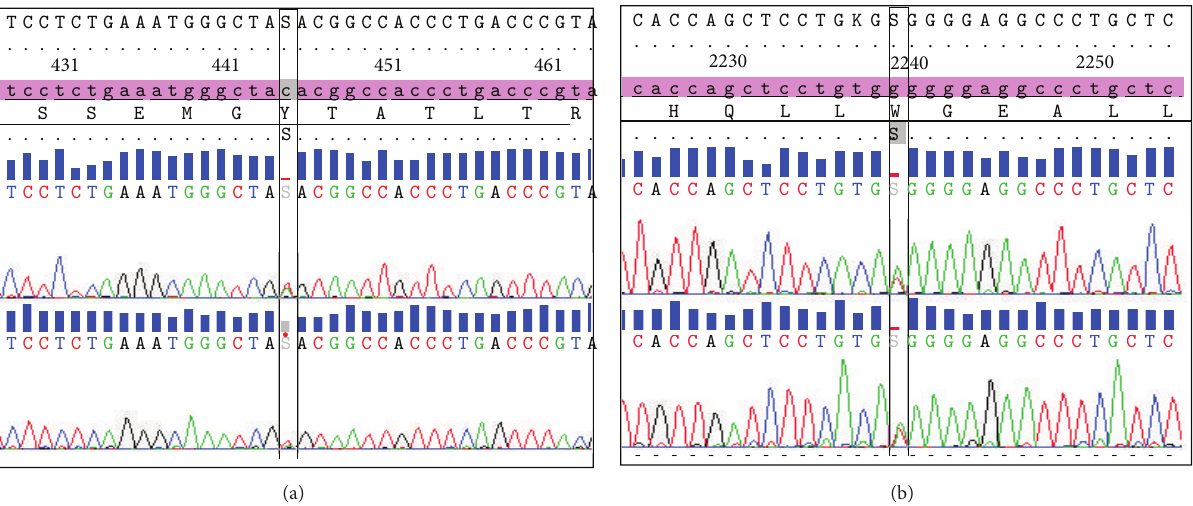
Figure3:DNAsequenceelectropherogramsofthetwoheterozygouscompoundsdetectedinthispatient.Thec.444C > G(p.Tyr14 8 ∗ )mutation is identified in exon 2 and c.2238G > C (p.Trp746Cys) mutation is identified in exon 16 of the GAA gene.